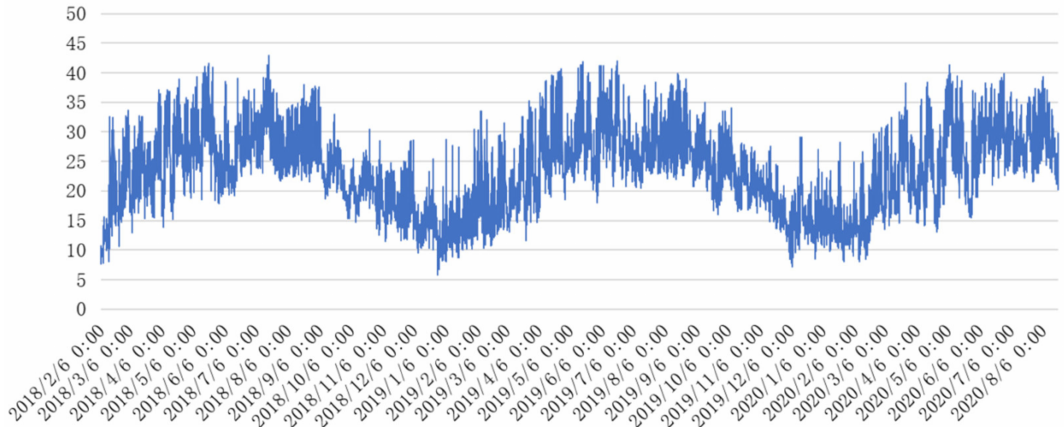
Figure 2. Regional Average Air Temperature Change